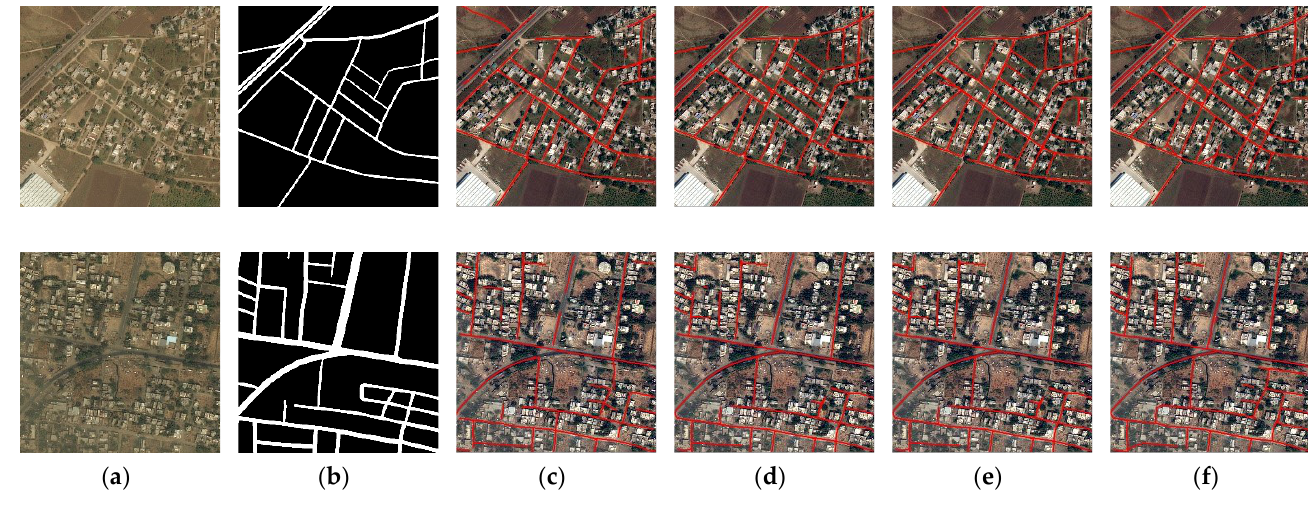
Figure 8. Visual comparisons of road extraction results with different models on non-urban dense areas of the DeepGlobe dataset: ( a ) input test image; ( b ) corresponding ground truth image; ( c ) results using the LinkNet; ( d ) results of D-LinkNet; ( e ) results of RoadTracer; ( f ) results of proposed Bi-HRNet.